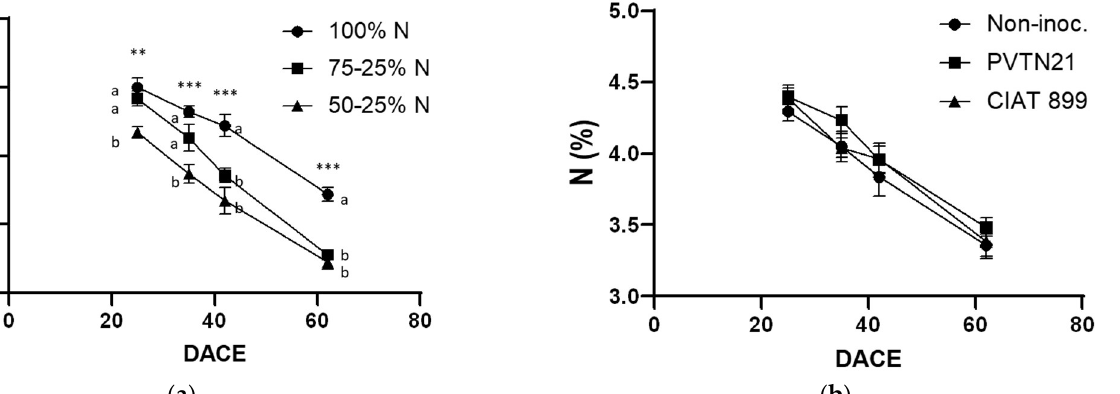
Figure 1. Total-N content in the aboveground biomass (shoots) of common-bean ( Phaseolus vulgaris L.) plants during vegetative-, flowering-, just-prior-to-pod-formation, and reproductive-growth stages (25, 35, 42, and 62 DACE, respectively). The graphs show: ( a ) the impact of different mineral-N treatments; and ( b ) inoculation with rhizobia . *** and ** denotes statistical significance according to Duncan’s multiple range test at p < 0.001 and p < 0.01,